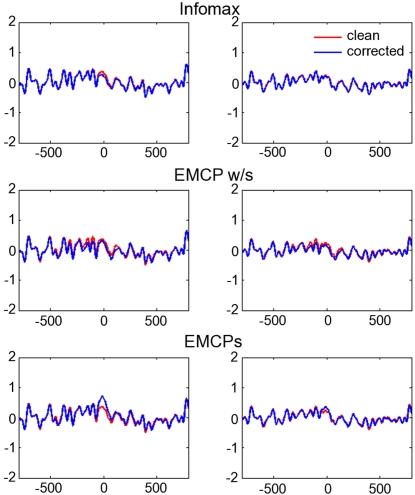
Component model.Averages time-locked to the maximum blink excursion (x-axis: time (ms); y-axis: µV). Only two channels are plotted (left and right column respectively). Red lines: clean, uncontaminated data; Blue lines: corrected data. Note the difference in the scaling for the EMCPs-corrected data. Also note that the real names (like “FCz”) are not informative, since they don't have spatial information. The reason is that the components were selected randomly for the mixing, as well as the values for the mixing matrix.